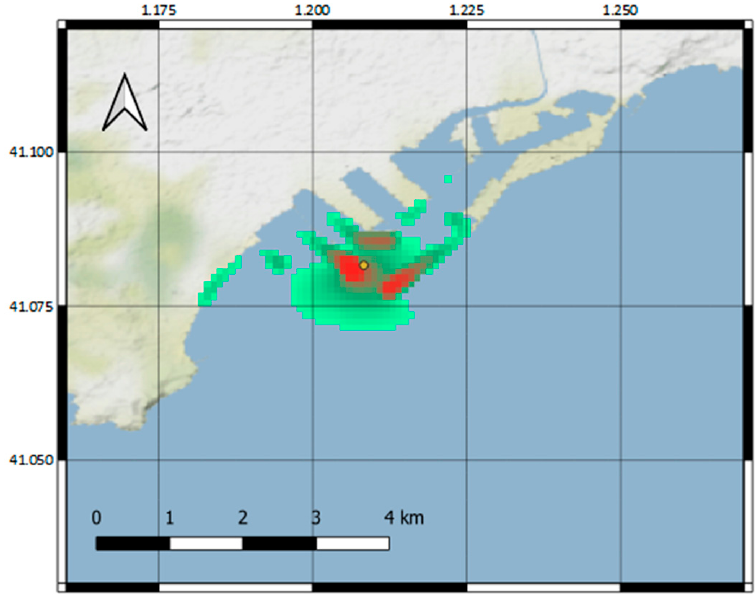
Figure 4. IPM for spills in the dock (yellow dot), evaluated on the port domain.